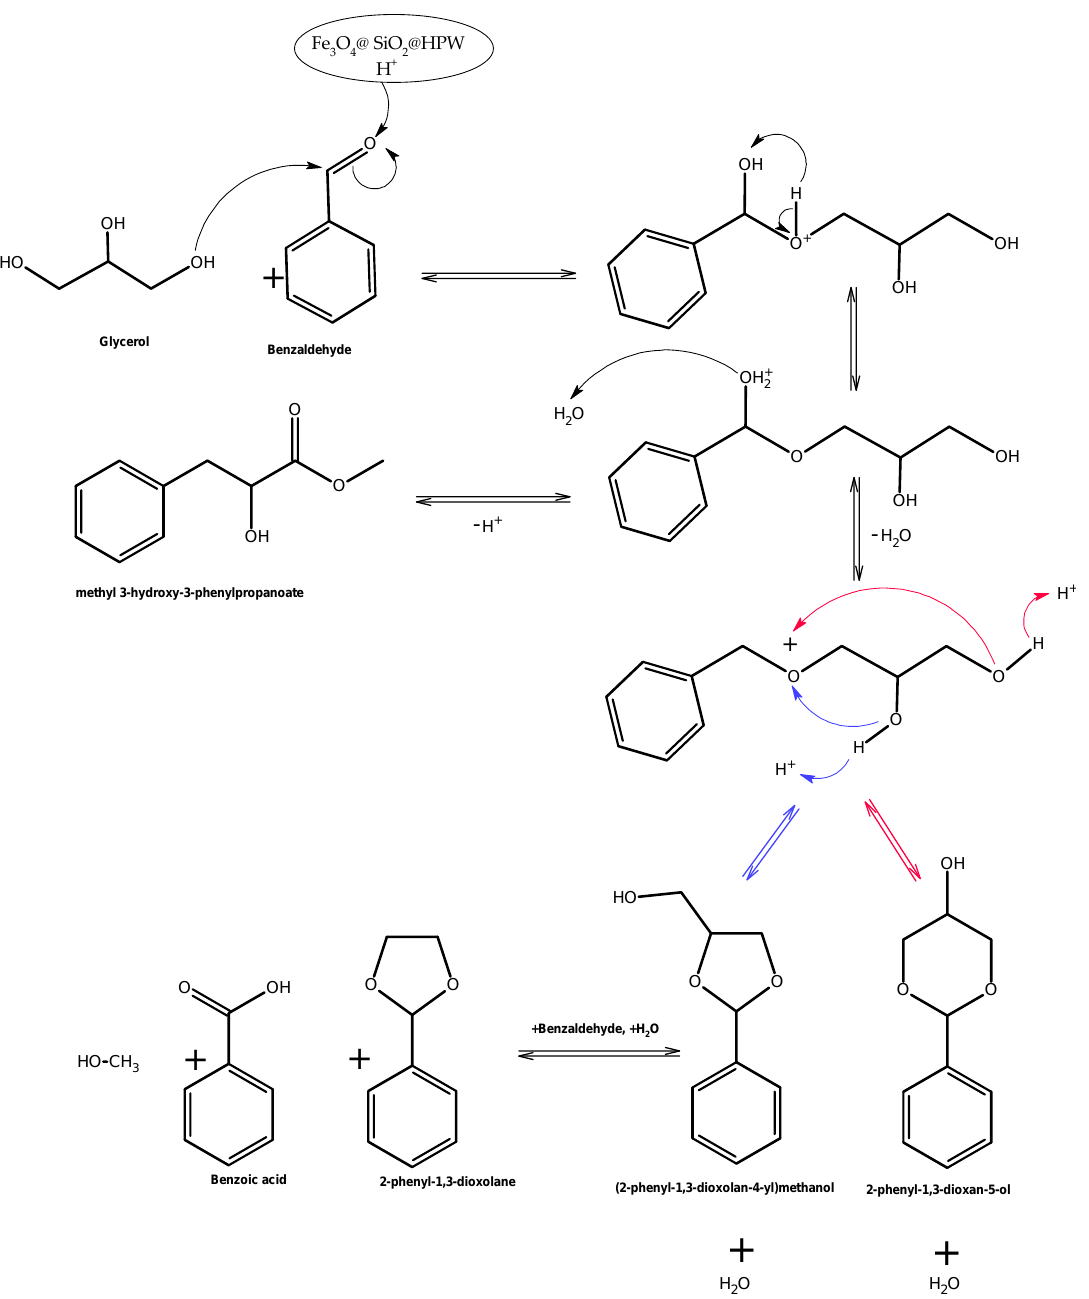
Figure 12. Reaction mechanism of acetalization of glycerol with benzaldehyde (based on the mechanism presented by Yamamoto et al. [77]) .